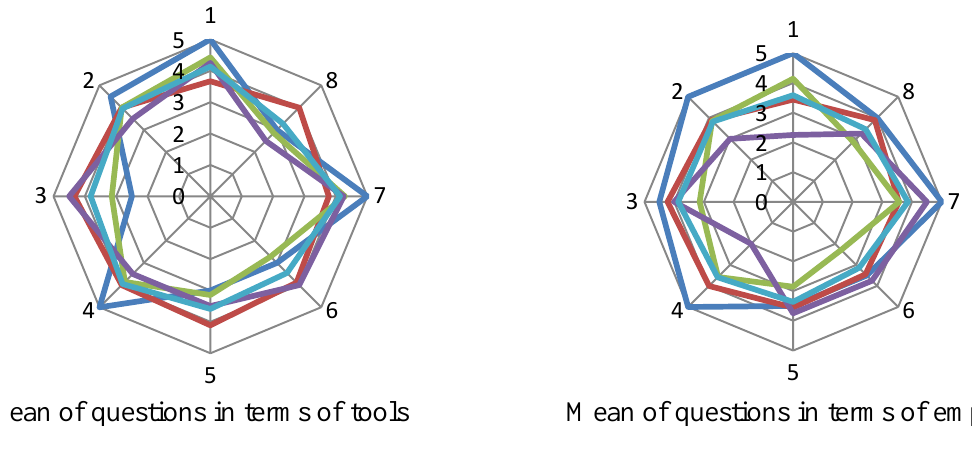
Fig. 2. The mean of responses to different groups of questions in terms of culture, project, tools and processes and